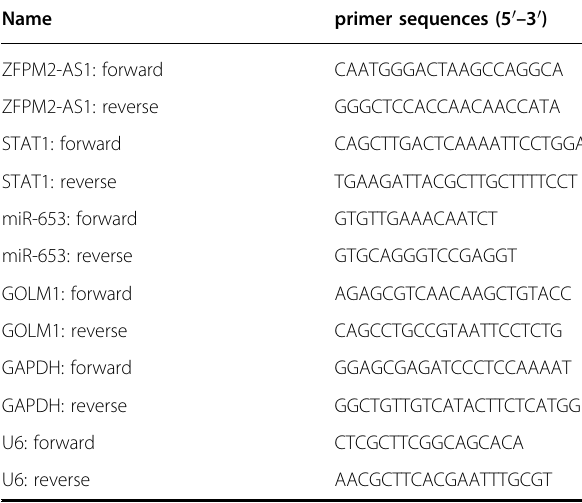
Table 3 The primer sequences included in this